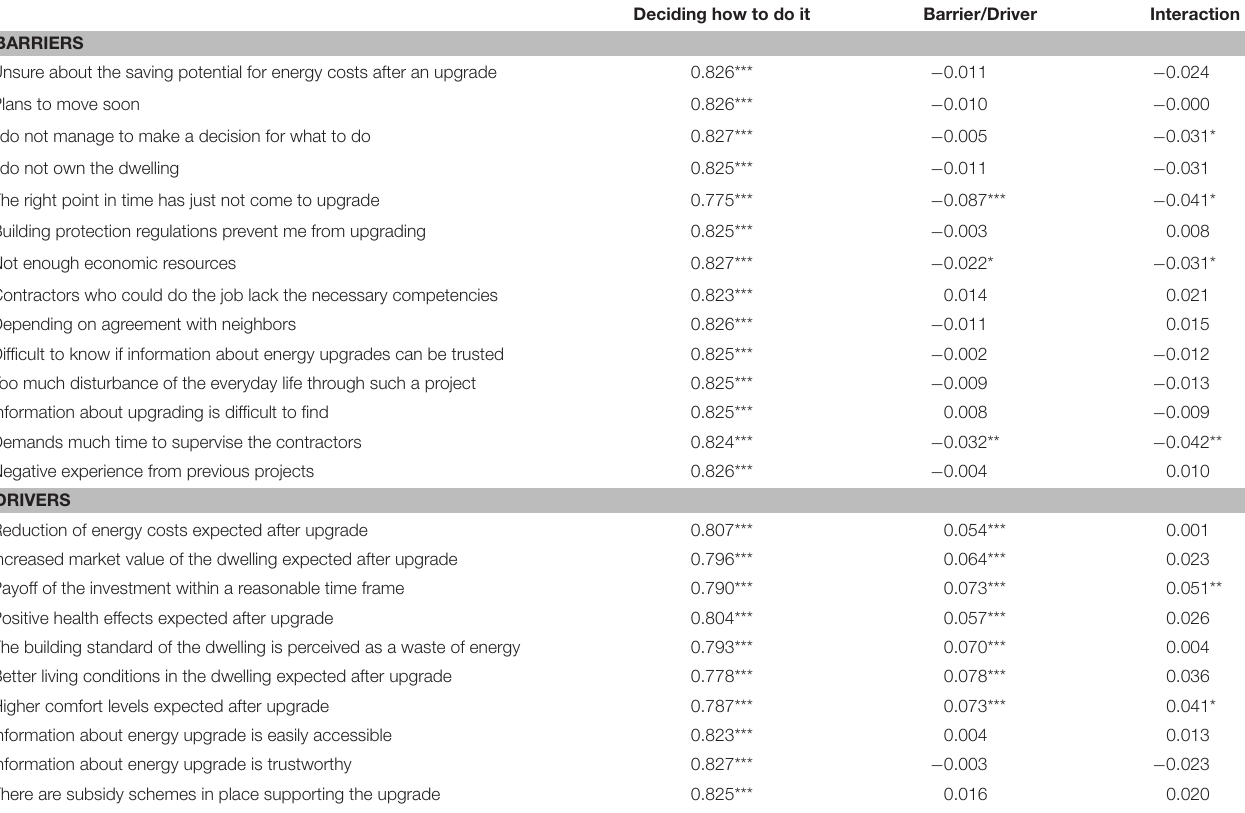
TABLE 5 | Analysis of the moderating effects of barriers and drivers on the transition from deciding how to do it to planning implementation ( N = 3.787). Deciding how to do it Barrier/Driver Interaction BARRIERS